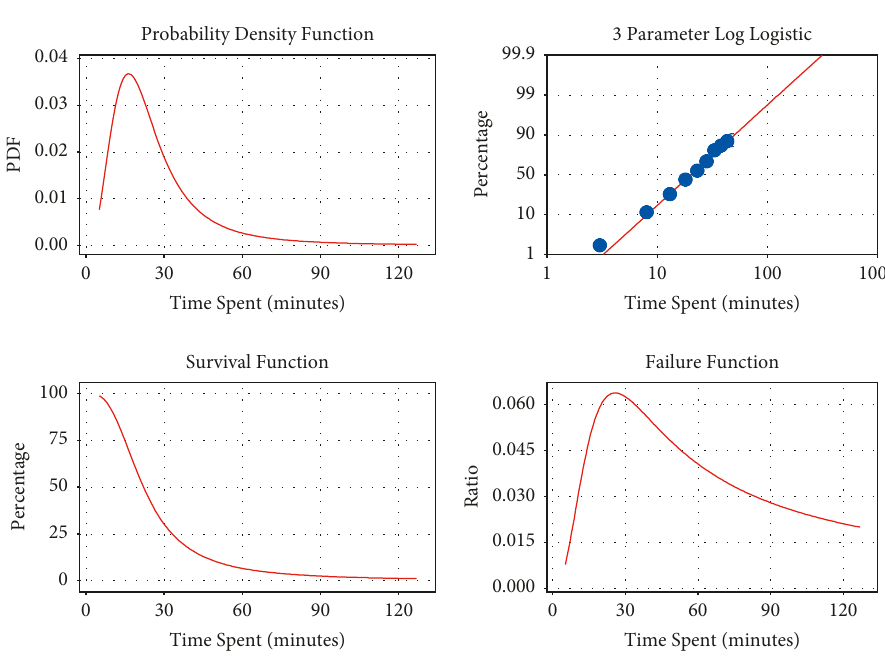
Figure 4: Distribution overview plot of time